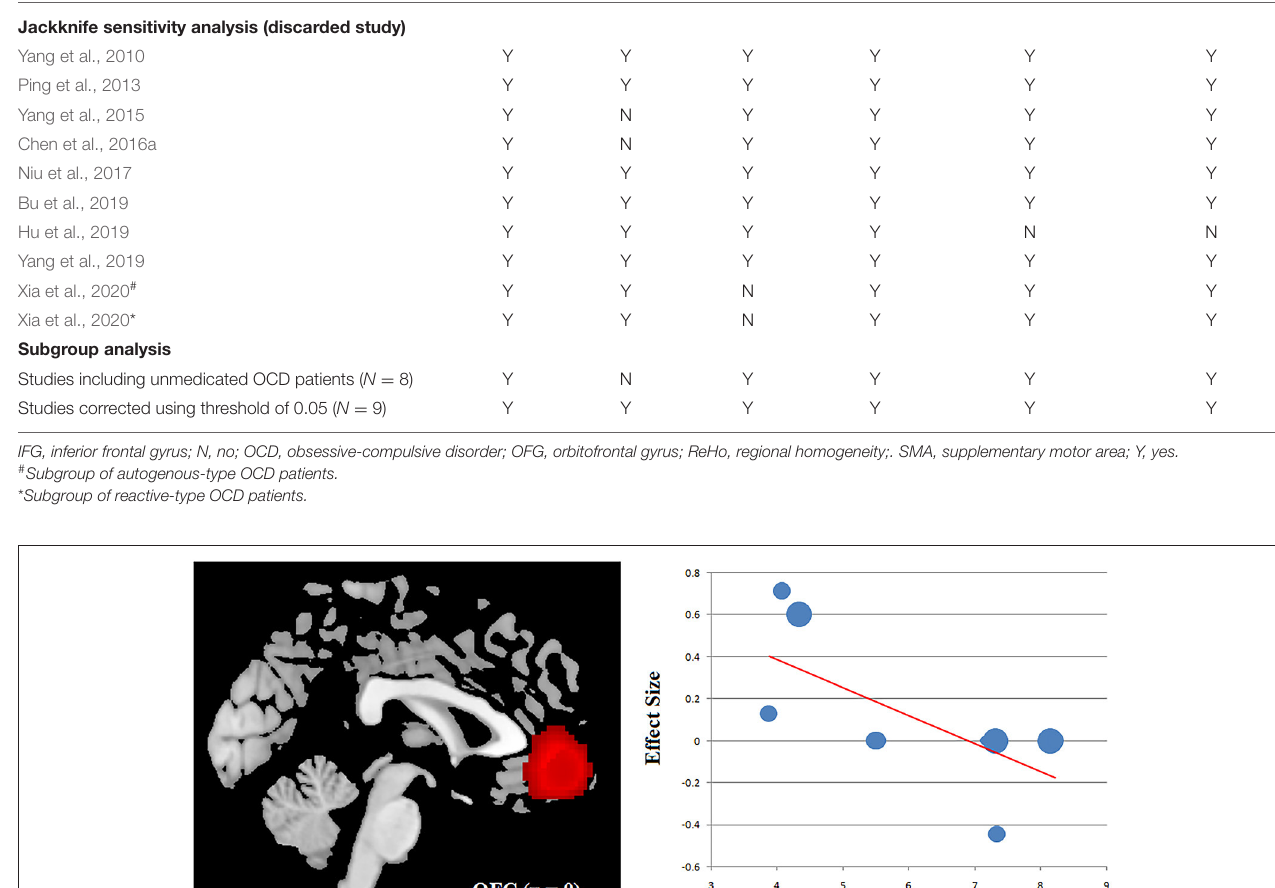
TABLE 4 | Sensitivity analyses of clusters with altered ReHo between OCD patients and controls from 9 included studies (10 datasets) in the current meta-analysis. Analysis Left IFG Right IFG Left OFG Right SMA Left cerebellum Right cerebellum